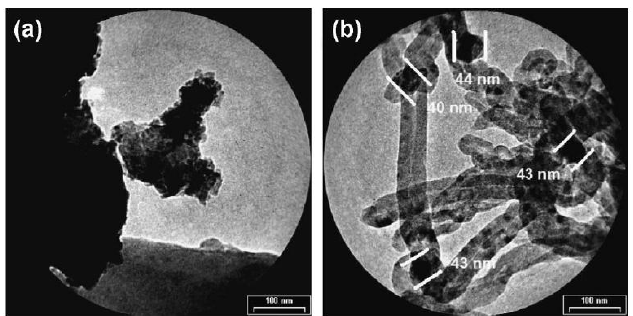
Figure 5. TEM pictures of the catalysts prepared by MW-assisted CS ( a ) and impregnation ( b ) after reaction. Reprinted from Appl. Catal. A Gen. , 378, Barros, B. S.; Melo, D. M. A.; Libs, S.; Kiennemann,